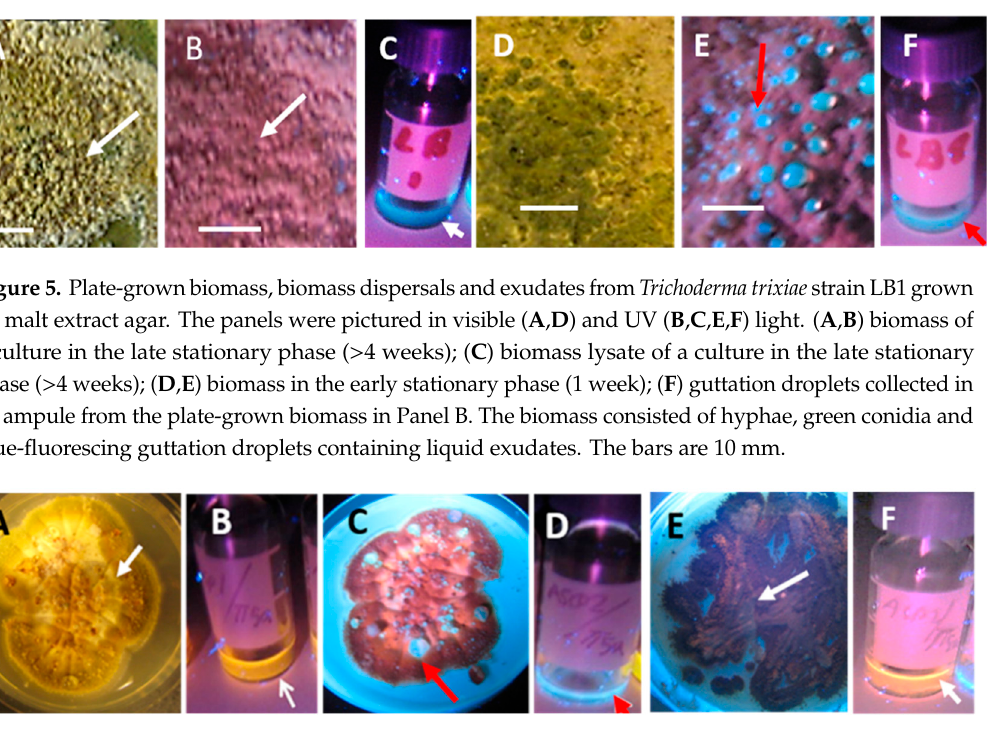
Figure 6. Colonies and biomass dispersals of Aspergillus versicolor strain Asp2/TT5a cultivated on malt extract agar, pictured in visible ( A ) and UV light ( B – D , F ). The colony cultivated for 7 days is yellow-green in visible light ( A ) and orange in UV light ( C ). Biomass scraped from the plate (( A ), white arrow), suspended in 200 µL ethanol emitted orange fluorescence in UV light (( B ), white arrow). The blue-fluorescing liquid droplets (( C ), red arrow) from the colony pictured in UV-light ( C ) were collected into an ampule (( D ), red arrow). Non-fluorescing biomass of the same strain covered by dormant conidia after 3 months of incubation (( E ), white arrow) emitted orange fluorescence when dispersed in ethanol (( F ), white arrow).